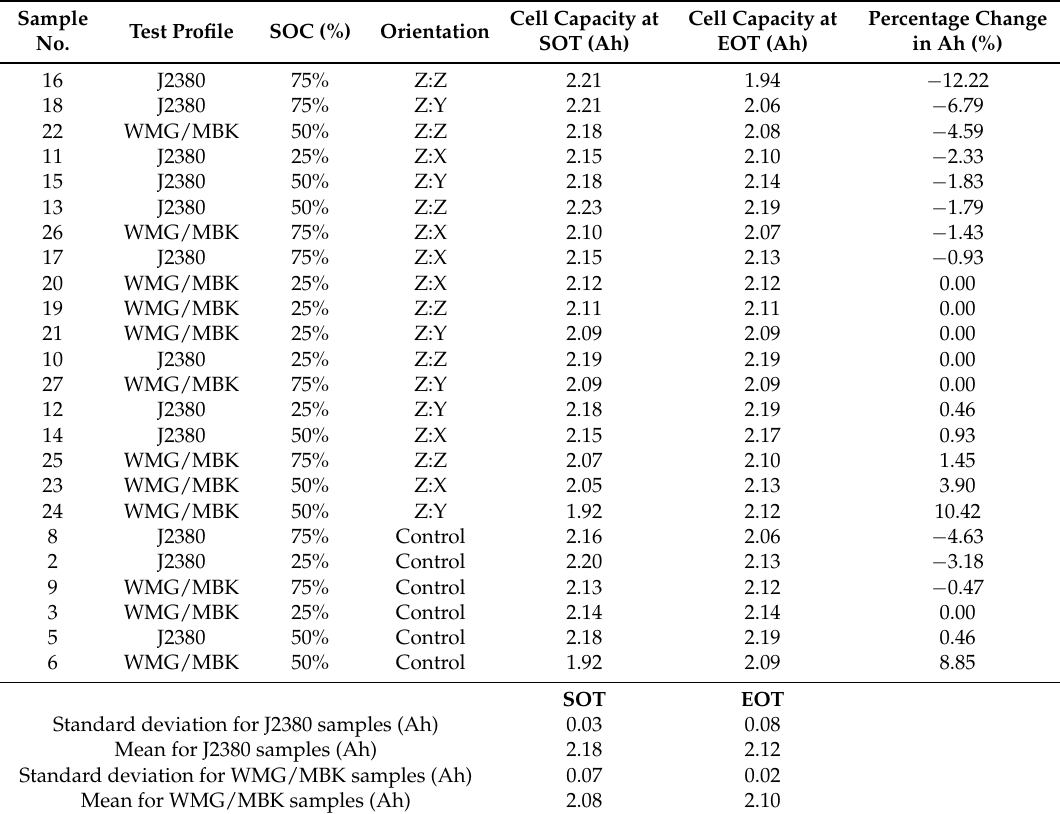
Table 9. Summary of change in 1C discharge capacity performance of all test